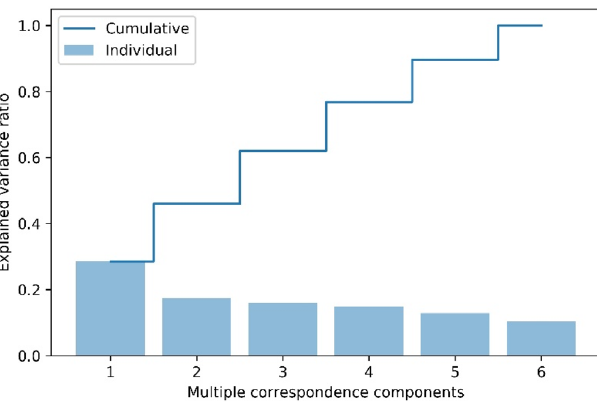
Figure 3. Conversion of categorical OCT biomarkers into different numbers of MCA components. The y axis showed the explained variance ratio, whereas the x axis showed the number of multiple correspondence components. It revealed that the first four components possessed nearly 80% explained